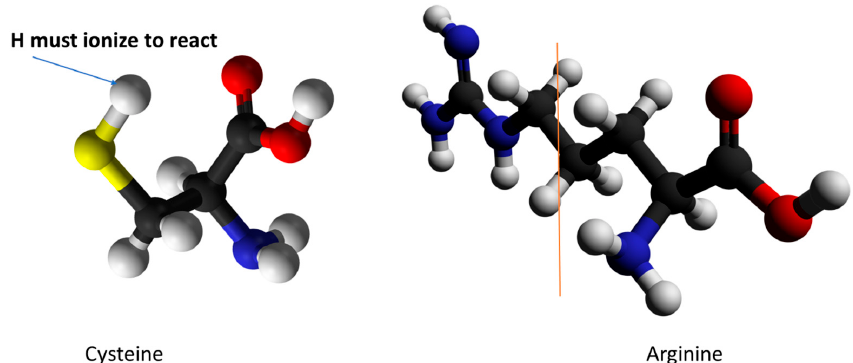
Figure 2. Comparison of cysteine and arginine: the section to the right of the vertical brown line on arginine approximates the volume that would accommodate a cysteine. If the hydrogen on the cysteine –SH ionizes, the cysteine becomes even smaller. The entire guanidinium group plus the proximate carbon take up space enough greater than the cysteine to be adequate for 2 to 3 water molecules. Beyond that line (to its left) on the arginine suggests the volume available for water or MTS reagent if arginine is replaced by cysteine.